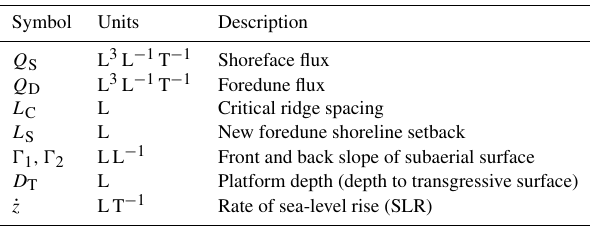
Table 2. Input parameters for Subaerial Barrier Sediment Partition- ing (SBSP)